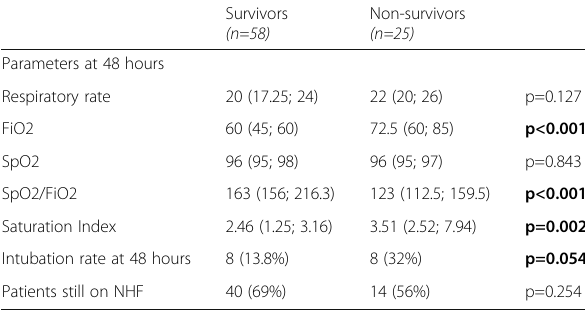
Table 1 (abstract 001141). Univariate